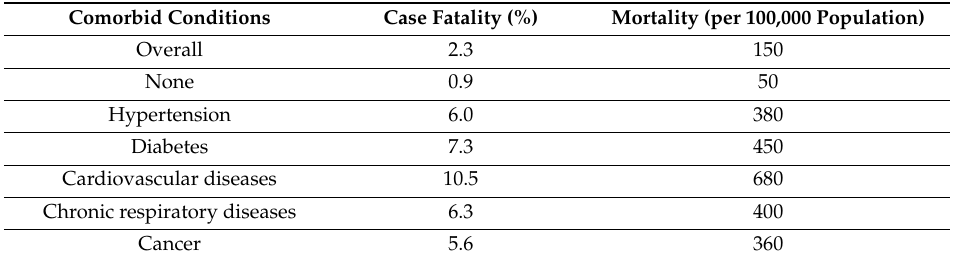
Table 1. COVID-19 Fatality and Mortality Rates on Comorbid Conditions in China.